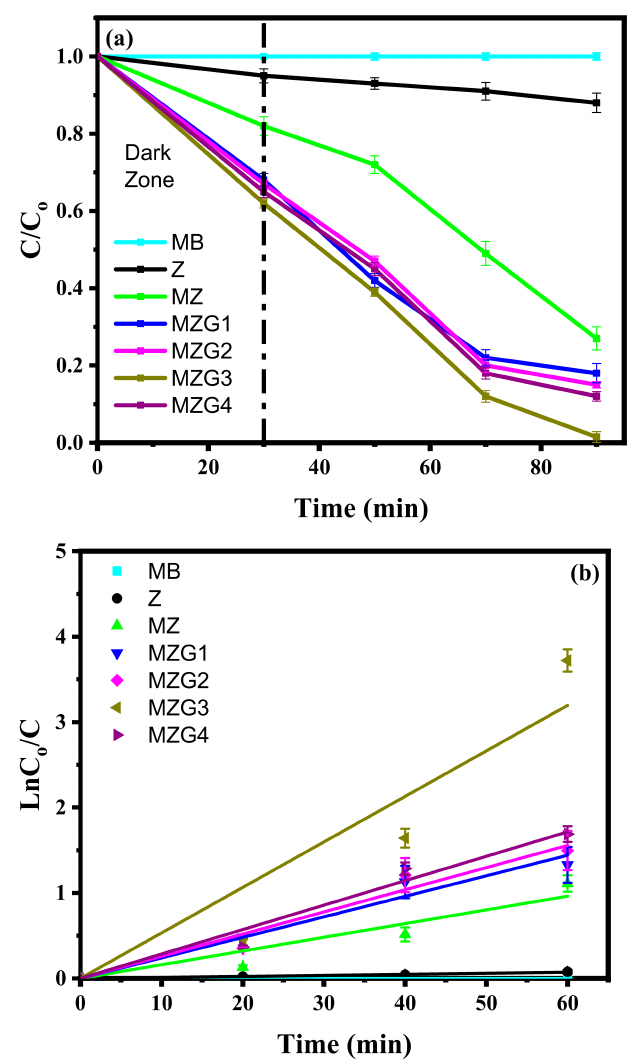
Figure 6. ( a ) Photocatalytic degradation and ( b ) kinetic photodegradation of methylene blue (MB) by no catalyst (MB), Z, MZ, MZG1, MZG2, MZG3, and MZG4 crystalline